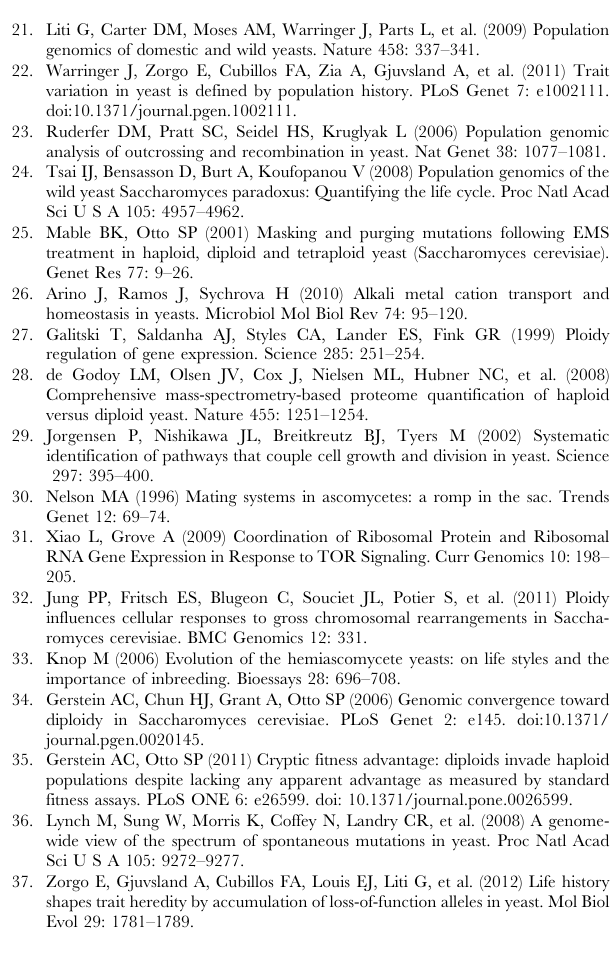
(n =16) and diploids (n= 16) and ena1 D 2 D 5 D haploids (n =8) and diploids (n =56) were microcultivated in 0.225M and 0.03M LiCl respectively and population doubling times were extracted. Note that data is shown on a log(2) scale. Error bars = SEM. P-values correspond to a homoscedastic, two-tailed Student’s t-test. The ploidy dependence of the doubling time during Li + exposure was unaffected by removal of the ENA genes, diploids growing significantly faster than haploids. Hence, the ploidy effect of Li + on mitotic growth rate is independent of the extrusion of Li + via the ENA genes. Table S1 Natural yeast isolates used in the study. ‘‘Population’’ refers to which of five S. cerevisiae or three S. paradoxus clean populations strain belongs to. For mosaic strains (containing genetic information from more than one population), the population donating the majority of the genetic information is indicated. ‘‘Source’’ refers to the source environment from which the strain was originally isolated. For YS9 ( MAT a ), and 322134S ( MAT a ), only one mating type was tested. Table S2 Environments used in the screen. ‘‘Carbon source’’ indicates that 2% glucose was substituted with the indicated concentration of the relevant carbon source. ‘‘Nitrogen source’’ indicates that 0.5% ammonium sulfate was substituted with the relevant nitrogen sources at nitrogen limiting concentrations (corresponding to 29 m g N/mL). Except for the addition of